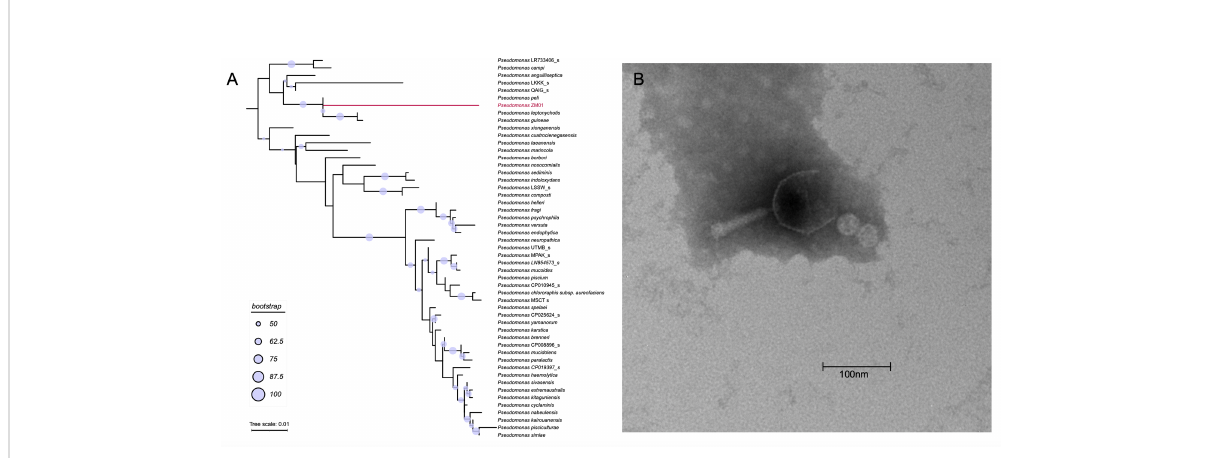
FIGURE 1 (A) The phylogenic tree based on the 16S rRNA gene of Pseudomonas ZM01 and other 120 reference 16S rRNA gene sequences of Pseudomonas ZM01. (B) Transmission electron micrograph of